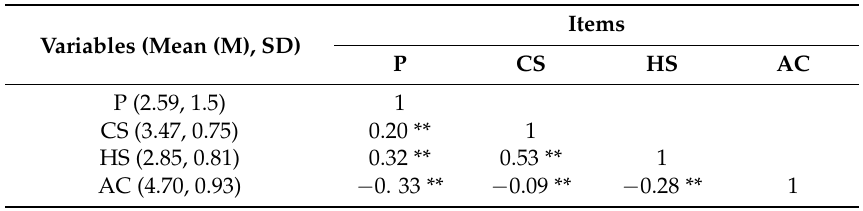
Table 3. Intercorrelations between presenteeism (P), challenge stress (CS), hindrance stress (HS), and affective commitment (AC) items (** p <